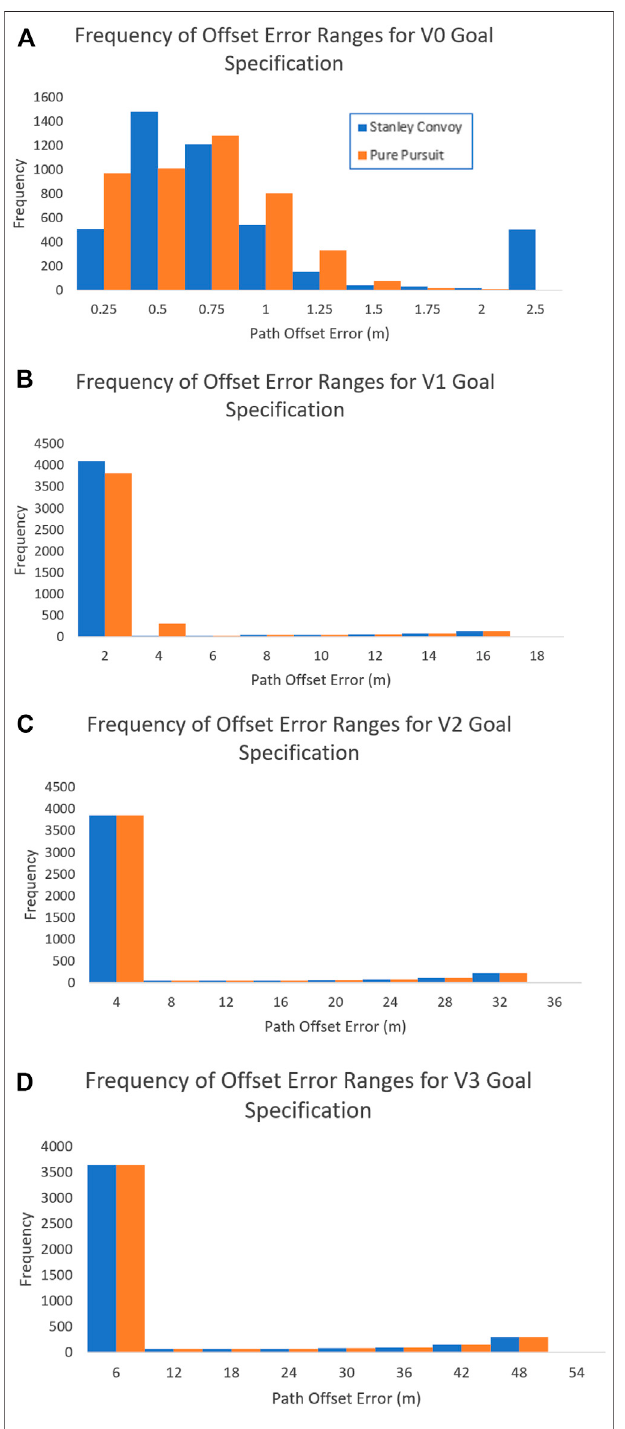
FIGURE 6 | Frequency of offset error ranges for Requirement 1 for (A) Vehicle0, (B) Vehicle1, (C) Vehicle2,and (D) Vehicle3andRequirement6for (E) Vehicle 0, (F) Vehicle 2, and (G) Vehicle